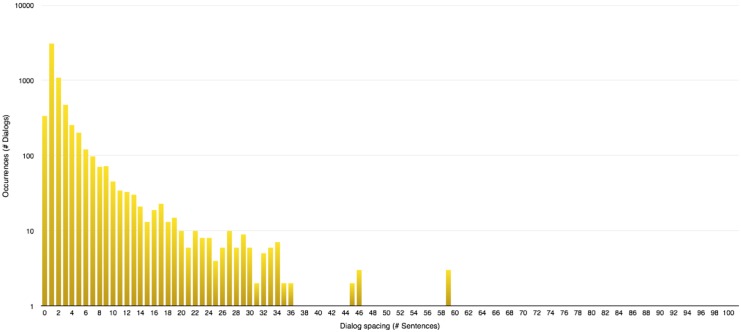
Dialog spacing distribution in “Les Misérables” [47].